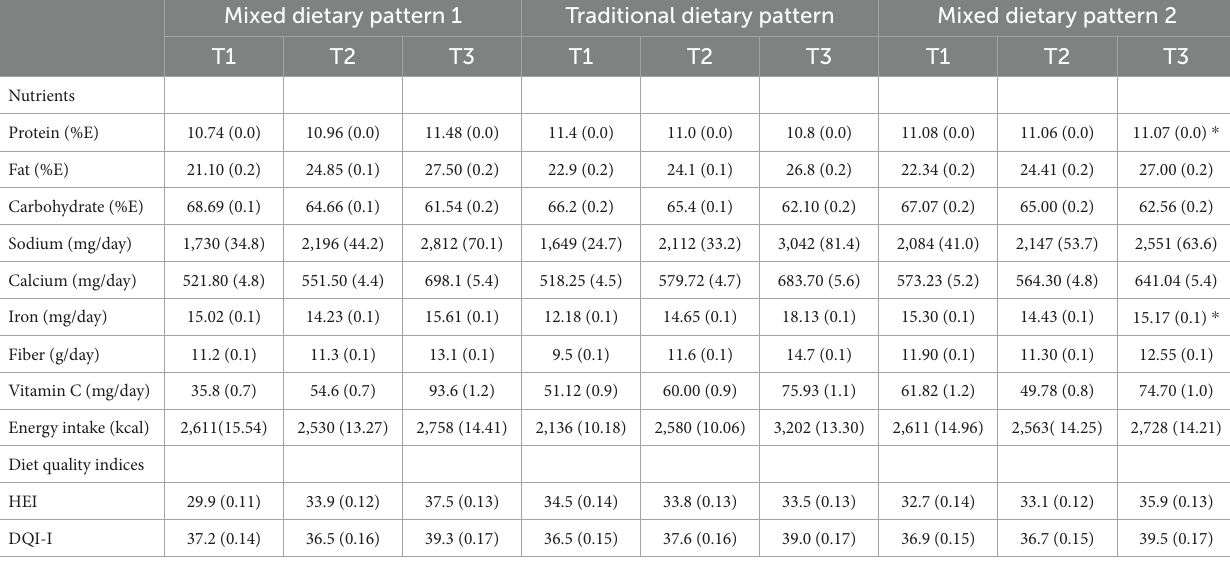
TABLE 2 Household nutrient intakes and diet quality indices according to tertiles of dietary patterns ( n = 6,833 households) 1 . Mixed dietary pattern 1